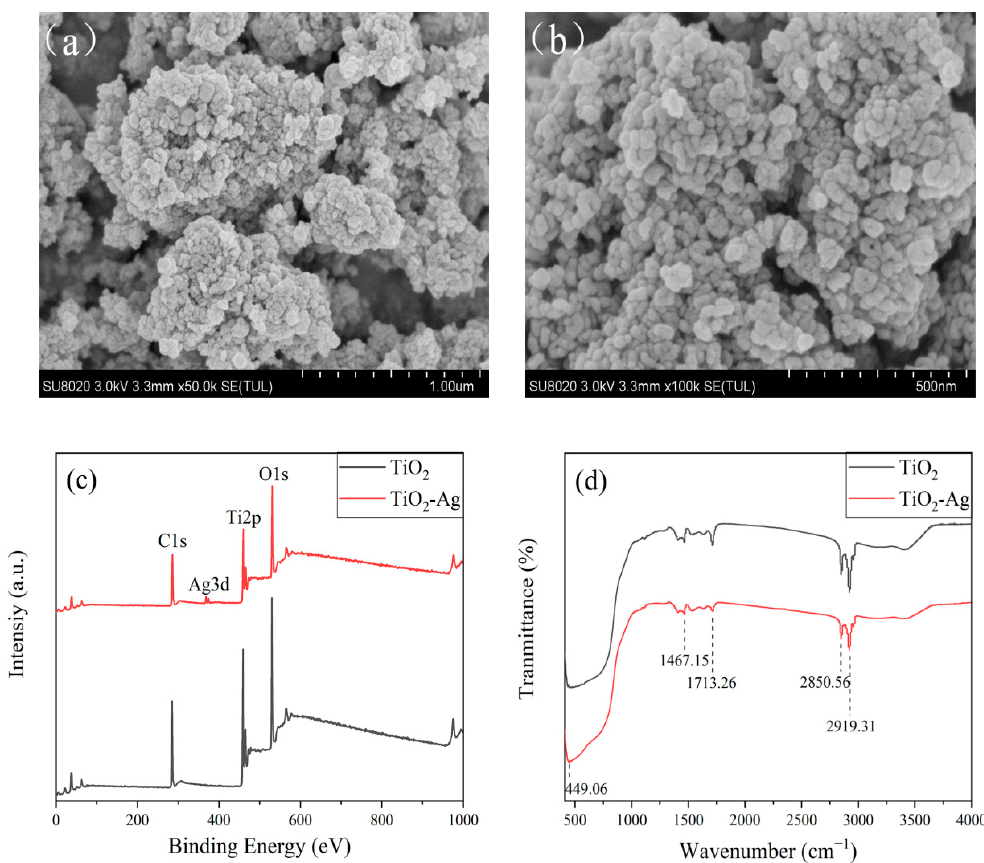
Figure 1. Characterization analysis diagram of TiO 2 -Ag: ( a ) SEM (1 μ m) images of TiO 2 -Ag; ( b ) SEM (500 nm) images of TiO 2 -Ag; ( c ) XPS spectra of TiO 2 -Ag; ( d ) FT-IR spectrum of TiO 2 -Ag.